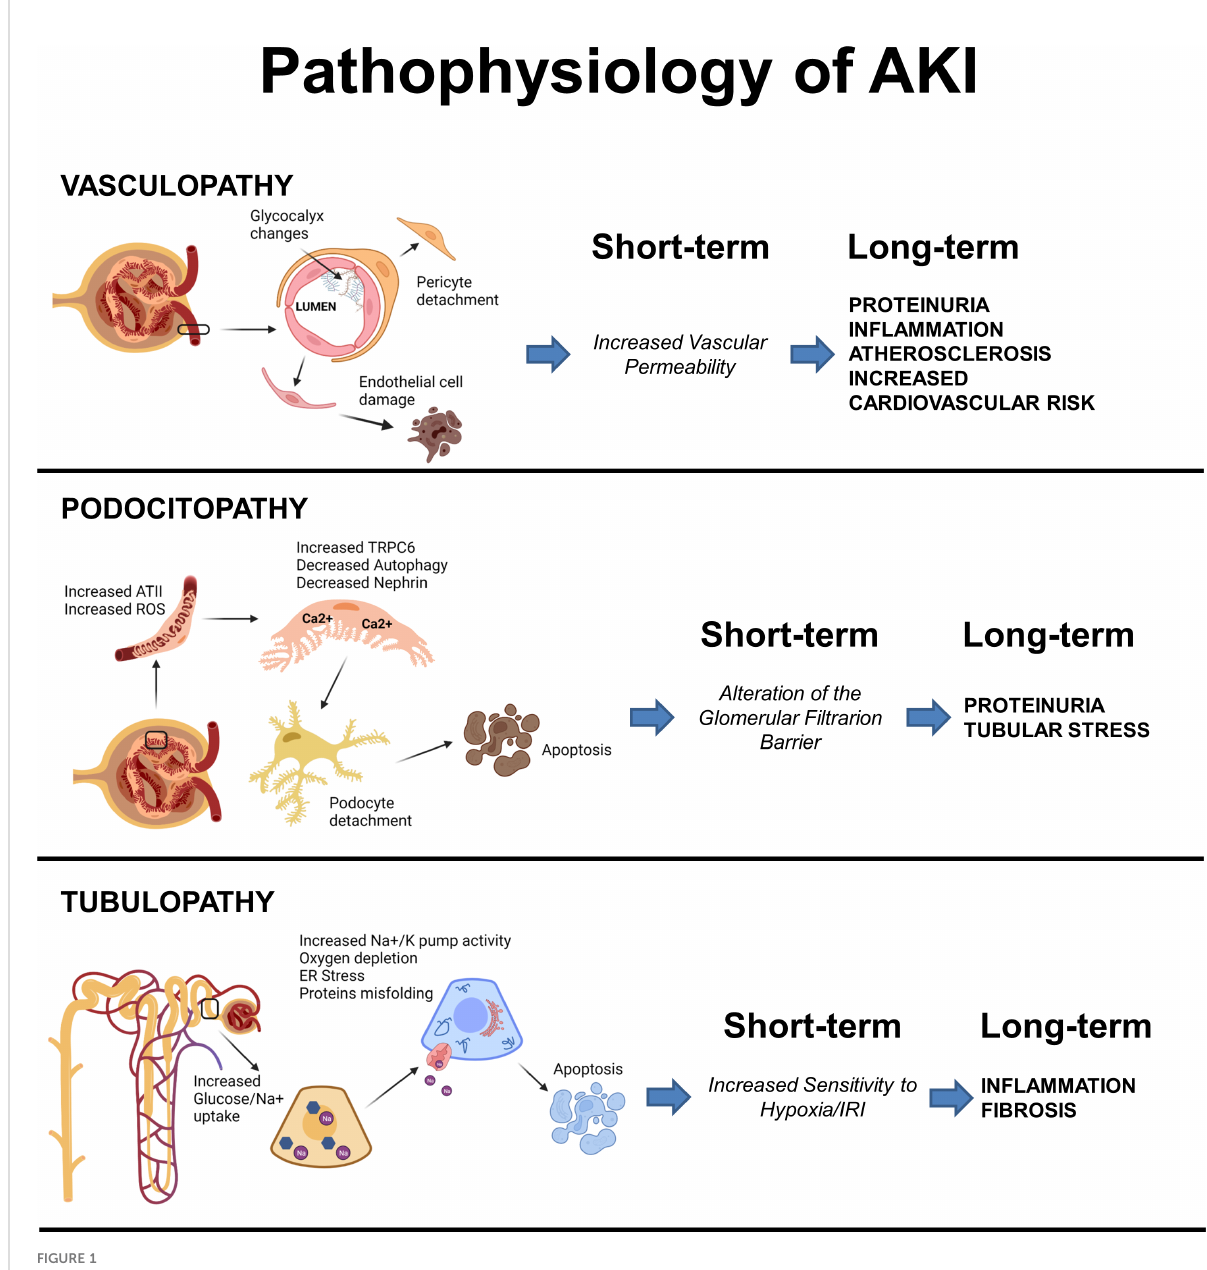
FIGURE 1 Schematic illustrationof the main events driving vasculopathy,podocitopathy and tubulopathy in AKI and Diabetes. Created with